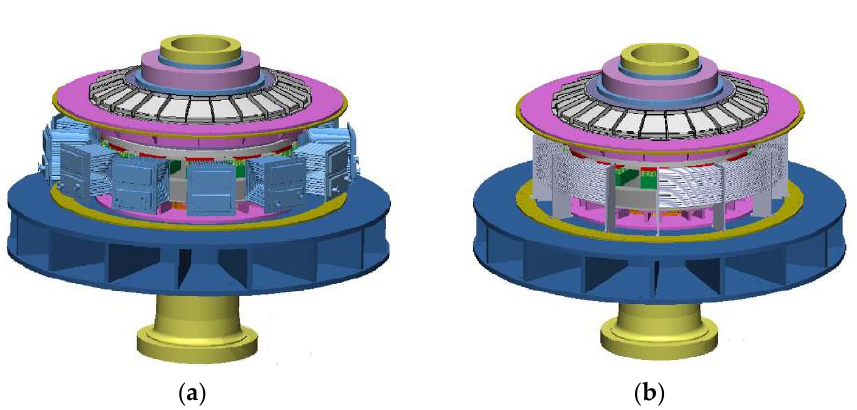
Figure 12. Model of lubricating oil internal circulation cooling thrust bearing [114]. ( a ) Thrust bearing models with drawer-type oil cooler; ( b ) thrust bearing models with vertical-type oil cooler.